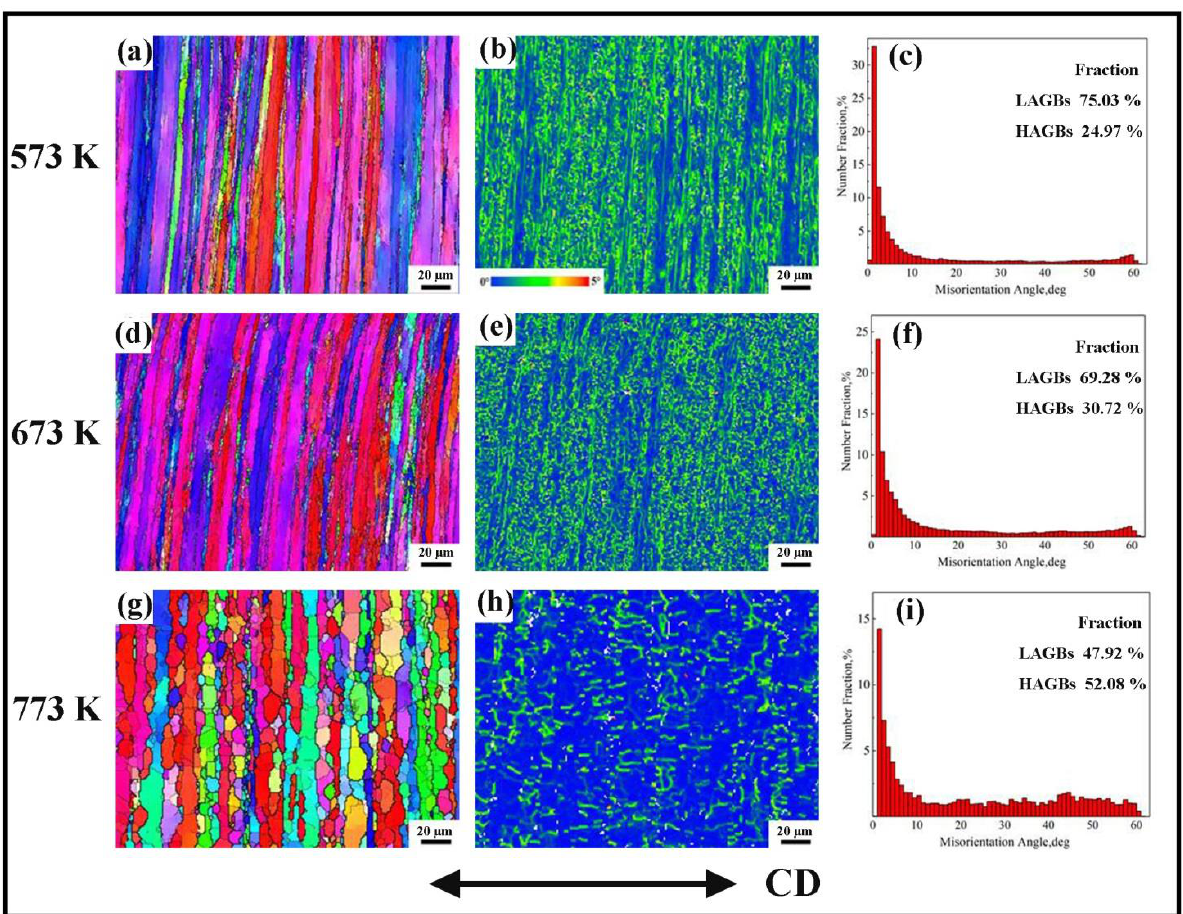
Figure 10. IPF maps, KAM maps and statistics of misorientation angle at different temperatures . ( 𝜀̇ = 0.1 𝑠 −1 ) ( a – c ) T = 573 K; ( d – f ) T = 673 K; ( g – i ) T = 773 K.